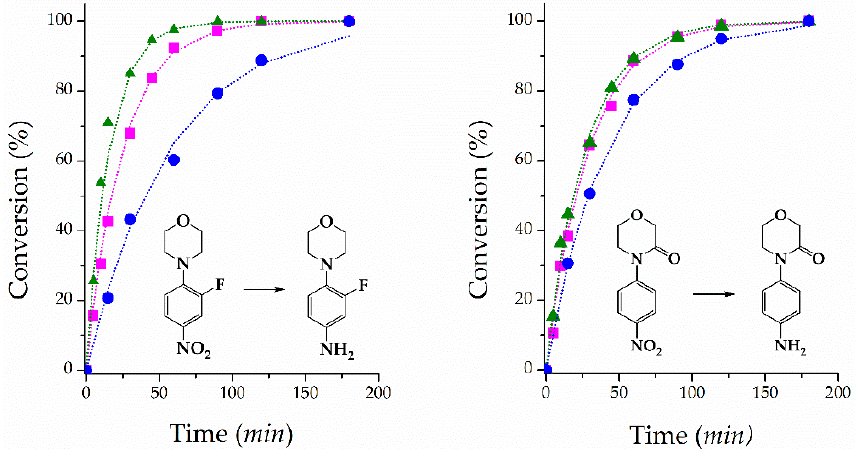
Figure 6. Conversion curves as a function of time for hydrogenation of the substrates of pharmaceutical interest on the catalysts (x)Au/ANW. ■— 0.25Au/ANW; ▲— 0.50Au/ANW and ● — 1.00Au/ANW. Straight lines correspond to the kinetic pseudo-first order